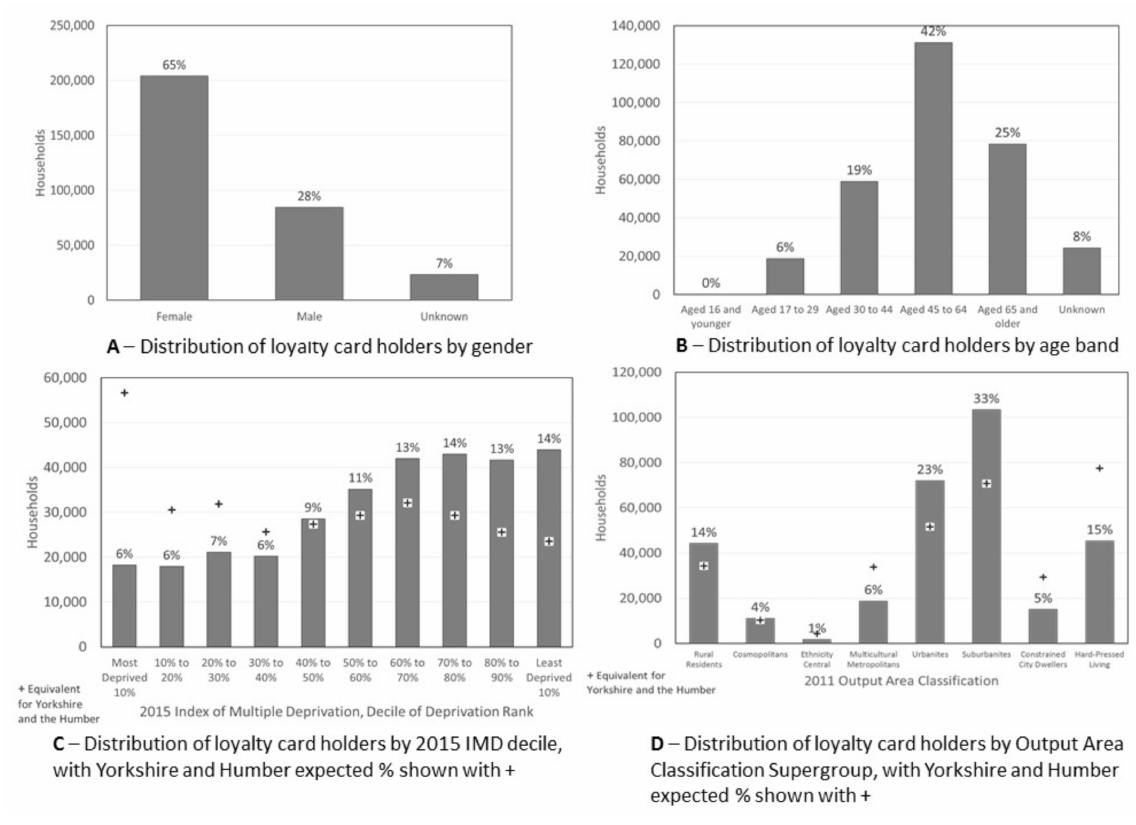
Figure 1. Characteristics of our loyalty card holders.